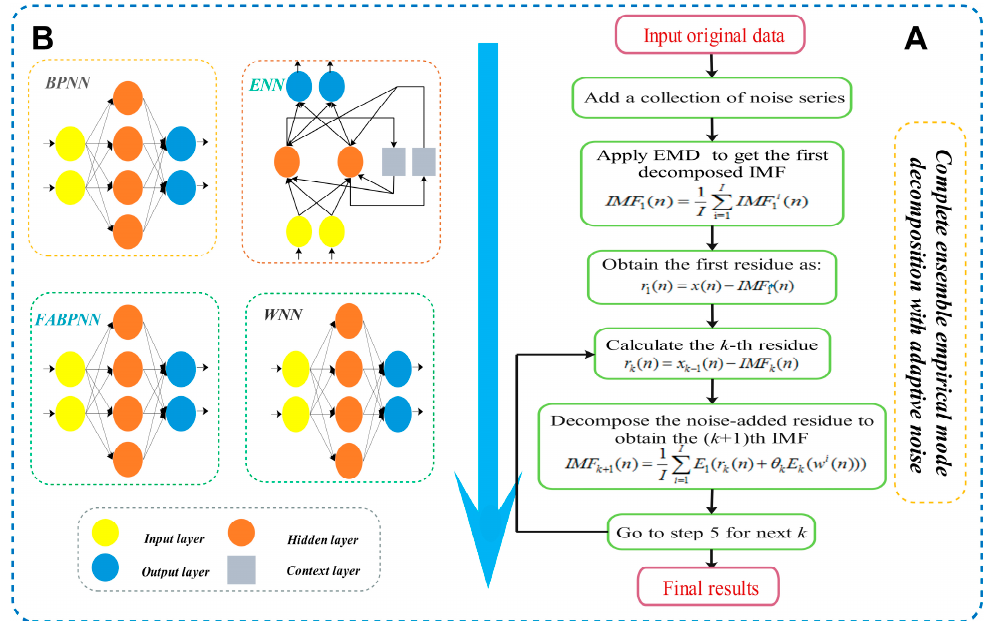
Figure 2. Structure of the individual models and complete ensemble empirical mode decomposition with adaptive noise (CEEMDAN). ( A ) Structure of the complete ensemble empirical mode decomposition with adaptive noise. ( B ) Structure of the individual models.